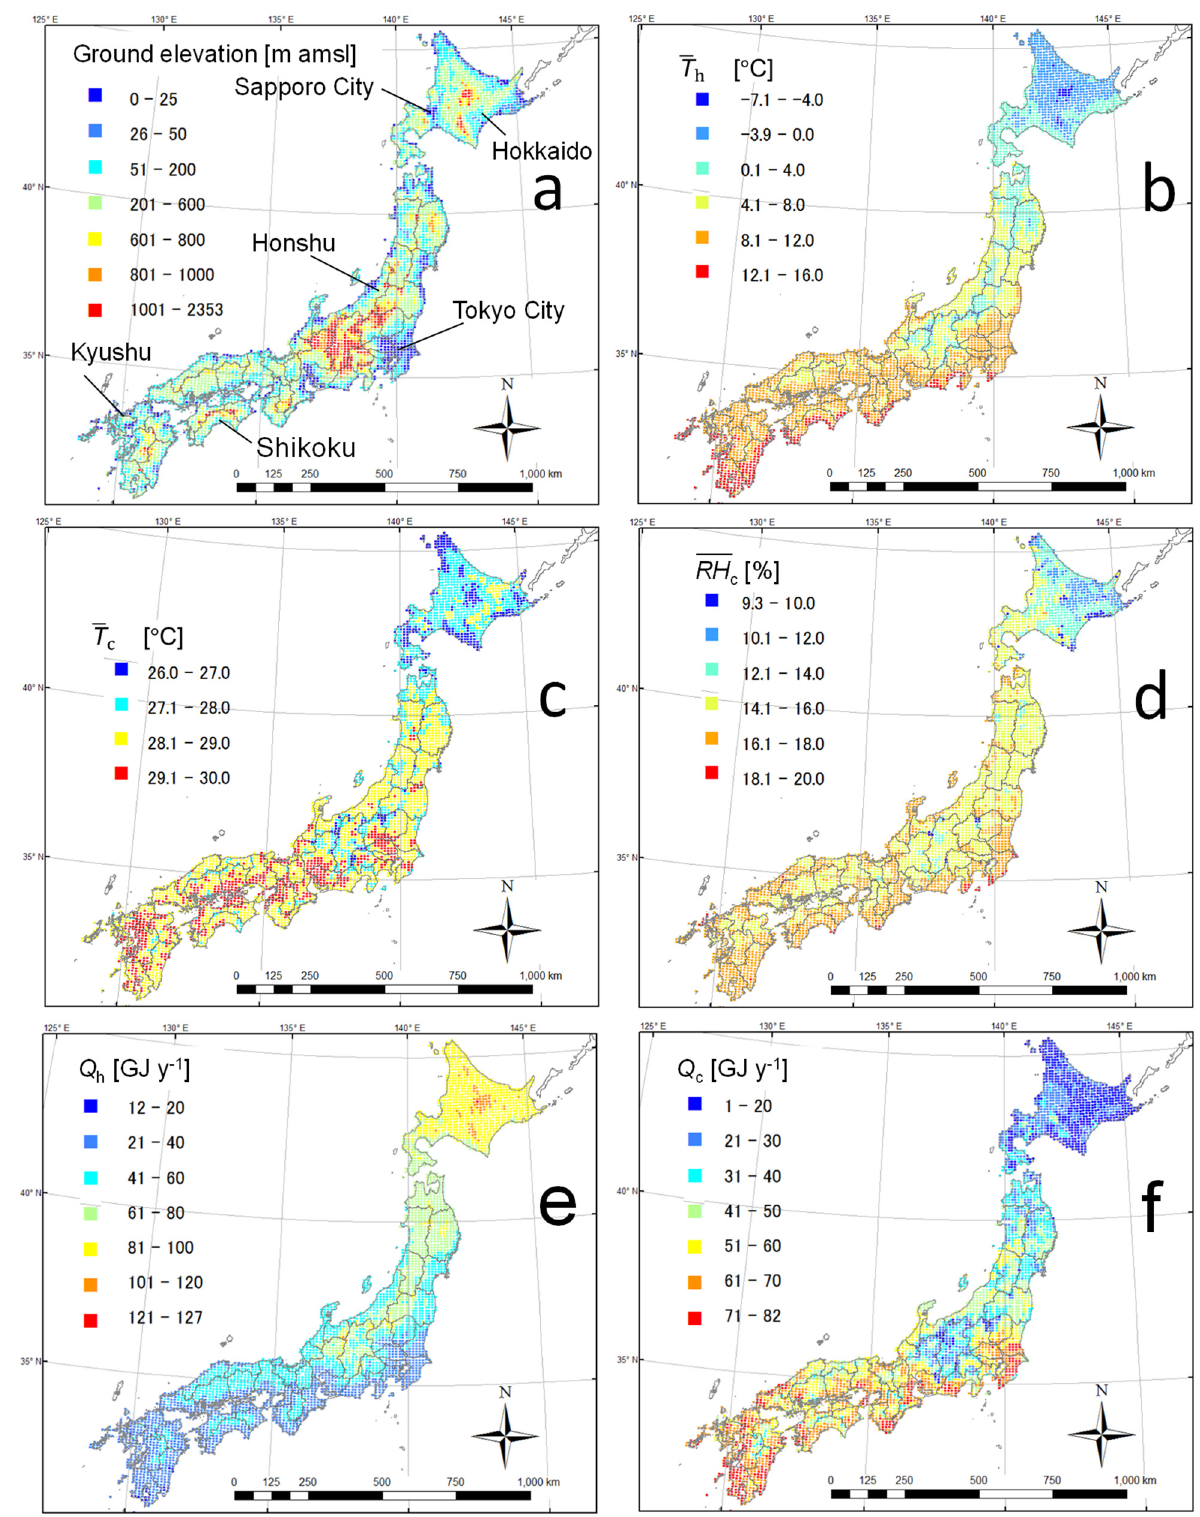
Figure 2. Topographical and climate maps of Japan: ground elevations [36] ( a ), averaged outdoor temperatures [37] during heating ( b ) and cooling ( c ), averaged outside humidity ( d ), and annual thermal loads for heating ( e ) and cooling ( f ) in a building of 300 m 2 . Each cell size is 10 × 10 km 2 . The thermal loads were estimated by the method of the Society of Heating, Air-Conditioning and Sanitary Engineers of Japan (SHASE) [38].